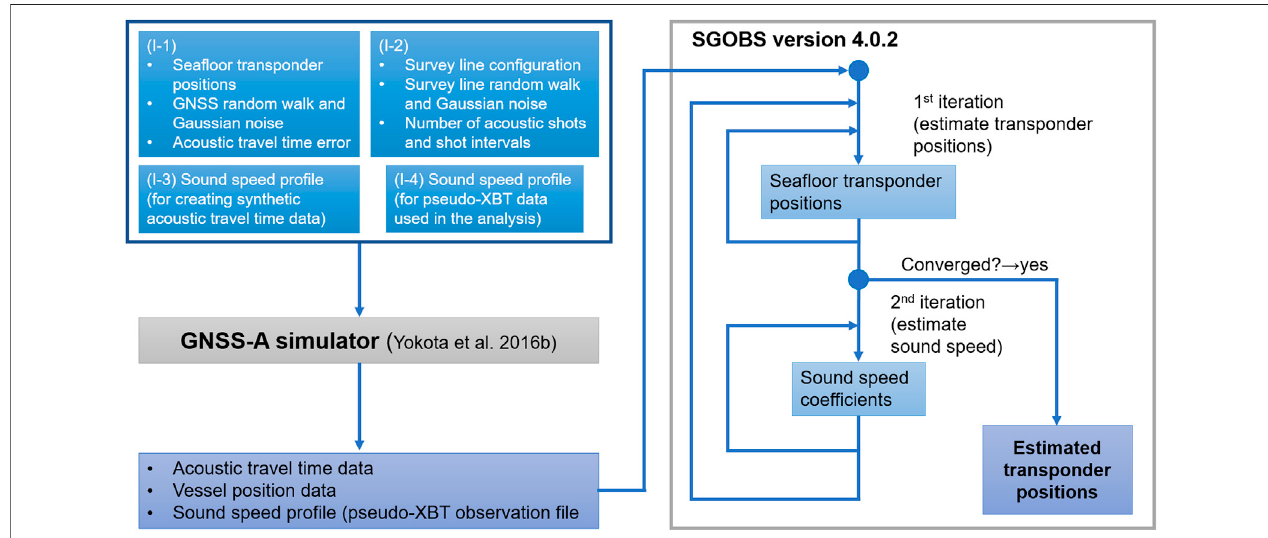
FIGURE 2 | The fl ow chart of our numerical experiment. The input fi les (I-1), (I-2), (I-3), and (I-4) are used for the con fi gurations of the numerical simulation by the GNSS-A simulator. The outputs of the GNSS-A simulator (the synthesized GNSS-A data) are analyzed using the analysis software SGOBS version 4.0.2, in which the linearized inversion method by Fujita et al. (2006) is implemented (right side of the fi gure).